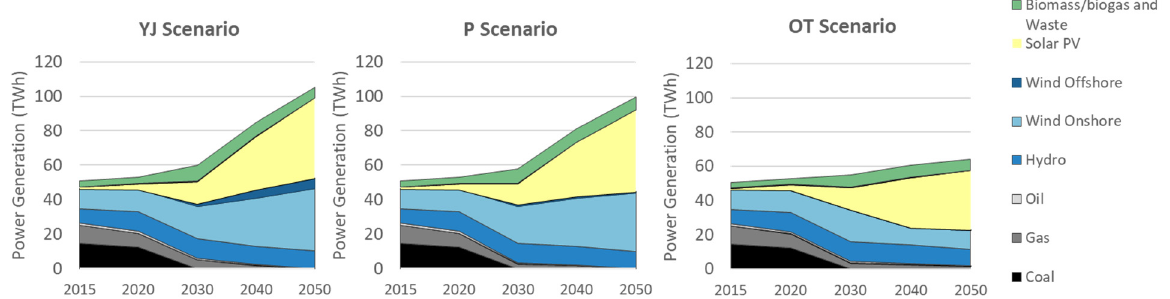
Figure 4. Power generation (TWh) per technology and scenario: Yellow Jersey (YJ), Pack (P), and Off Track (OT).